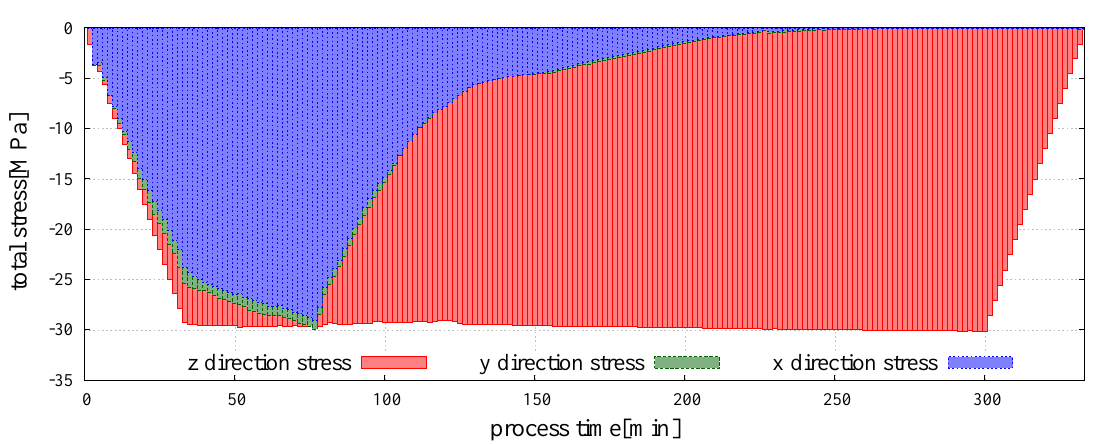
Figure 8. Evolution of total macroscopic stress of the hot pressing process in x , y , and z directions.